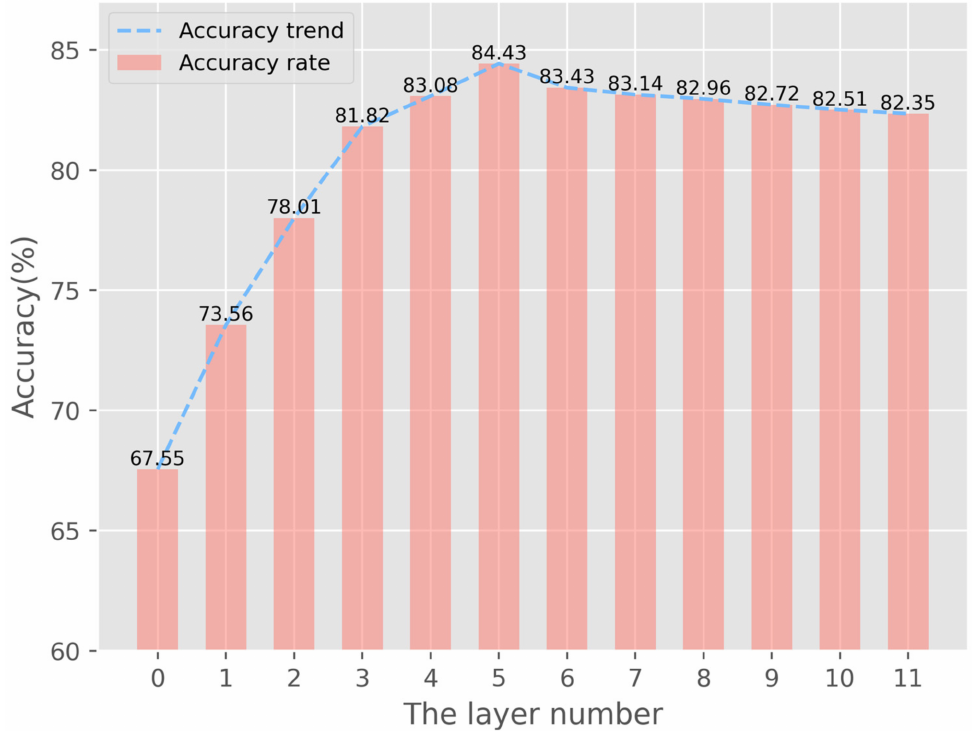
Figure 7. Effects of different layer numbers on classification